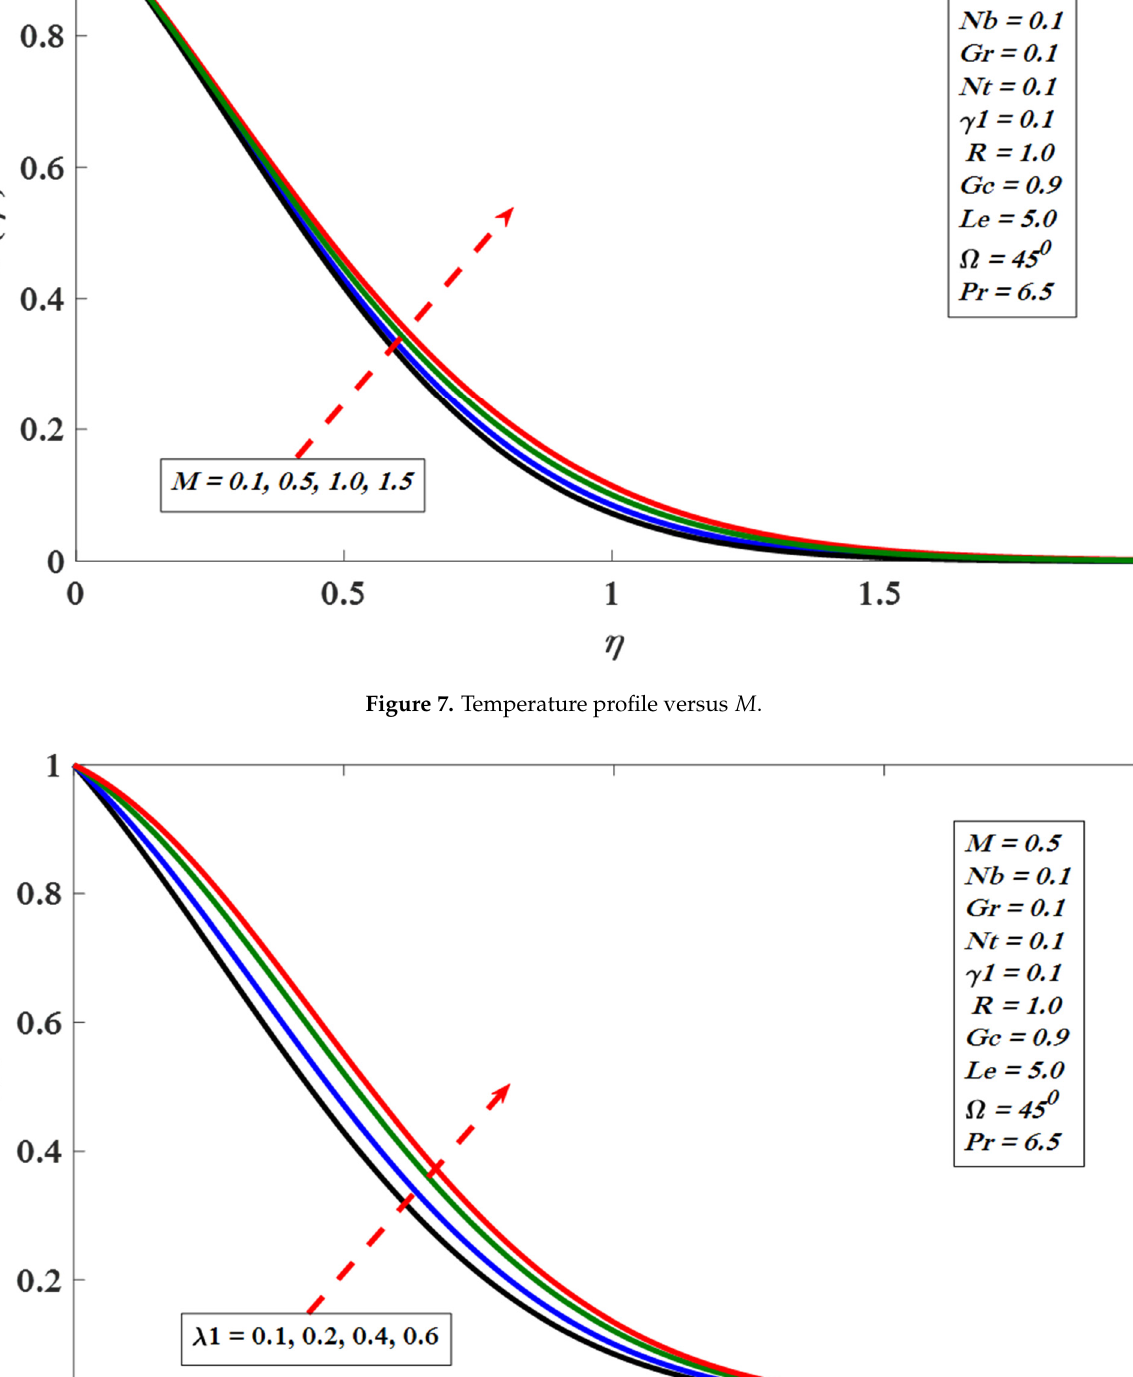
Figure 8. Temperature profile versus λ